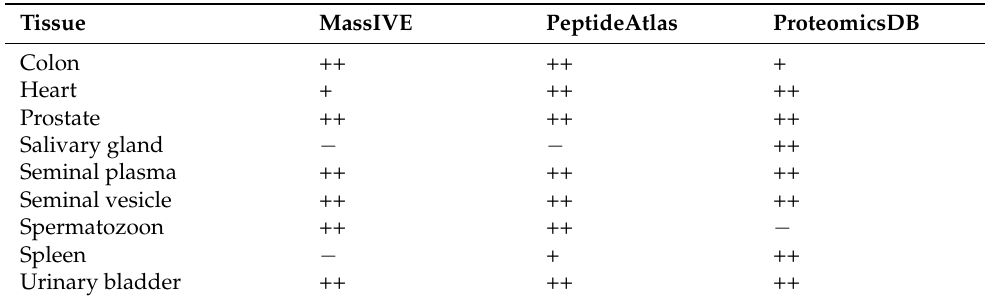
Table 1. Human TG4 expressing tissues based on detected unique peptides in MassIVE, PeptideAtlas or ProteomicsDB databases.